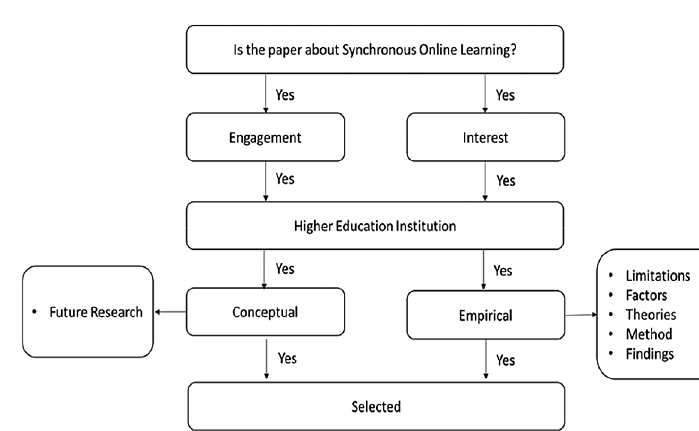
Figure 2. Data extraction and synthesis process.